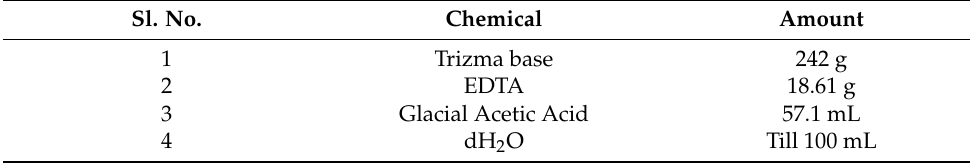
Table 5. Chemicals for 50 × TAE